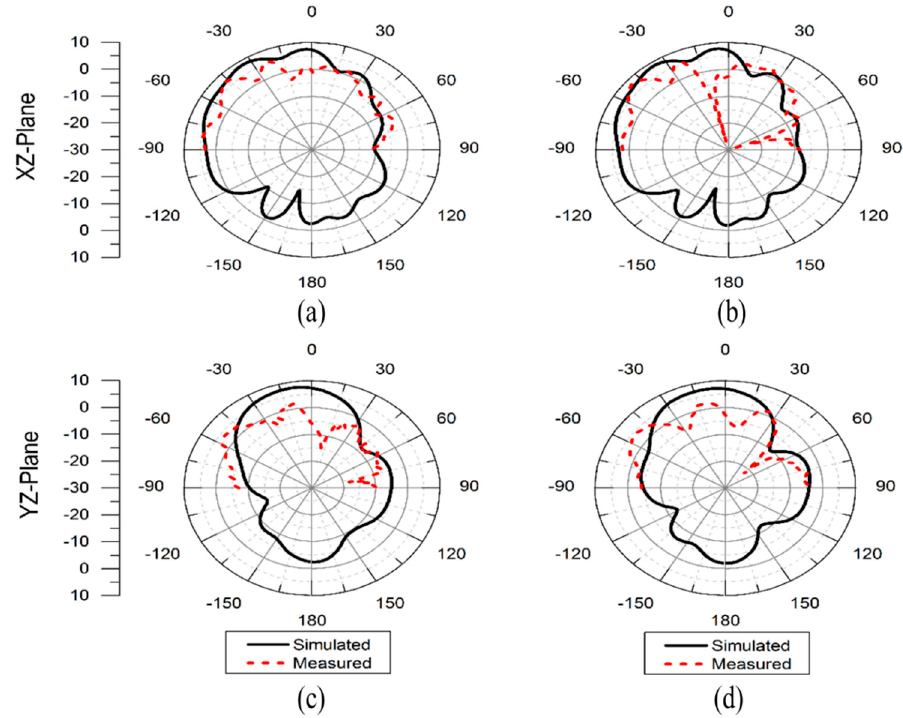
Figure 8. Measured and simulated 2D radiation pattern of antenna 1 ( a ) Radiation pattern at XZ-plane at 27.5 GHz ( b ) Radiation pattern at XZ-plane at 28 GHz ( c ) Radiation pattern at YZ-plane at 27.5 GHz ( d ) Radiation pattern at YZ-plane at 28 GHz.